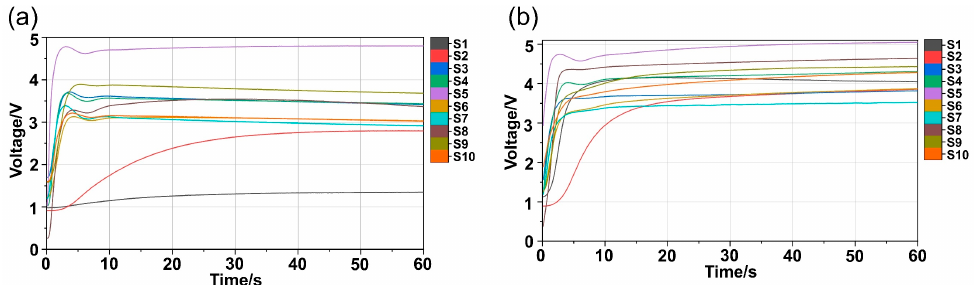
Figure 4. Sensor response curves: ( a ) 6.32 g/kg soil sample; ( b )78.71 g/kg soil sample.